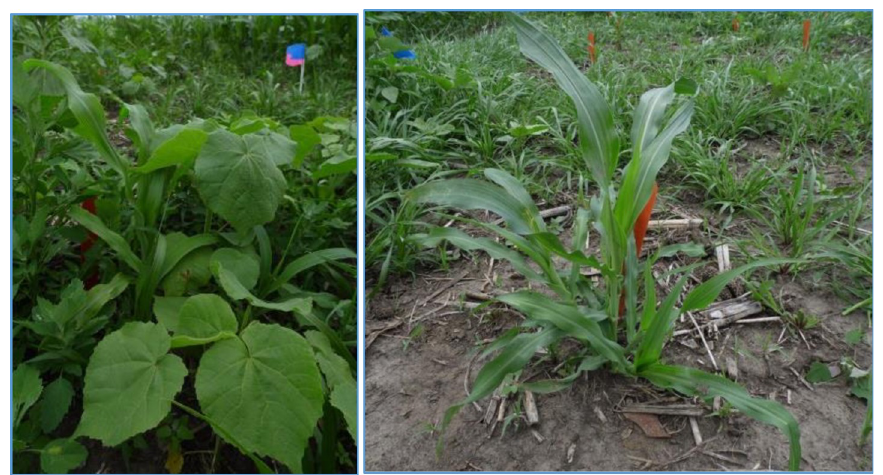
Fig 1. Teosinte ( Zea mays ssp . parviglumis ) in weedy and weed-free environments, early season. Abutilon theophrasti and Setaria glauca can be seen in the foreground (left) and background (right).